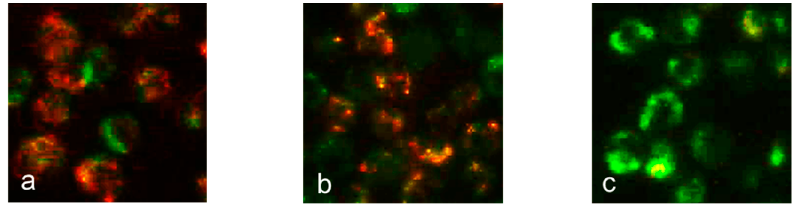
Figure 6. Effects of 11 or cisplatin on mitochondrial membrane potential in HL-60 cells. HL-60 cells were stained with MitoCapture TM reagent after the following treatments for 6 h (magnification, 200×): ( a ) control; ( b ) 10 µM of 11 ; and ( c ) 33 µM of cisplatin. Red fluorescence indicates accumulation of MitoCapture TM dye in the mitochondria due to normal mitochondrial membrane potential. Green fluorescence indicates cytosolic localization of MitoCapture TM dye in its monomeric form due to altered mitochondrial membrane potential.